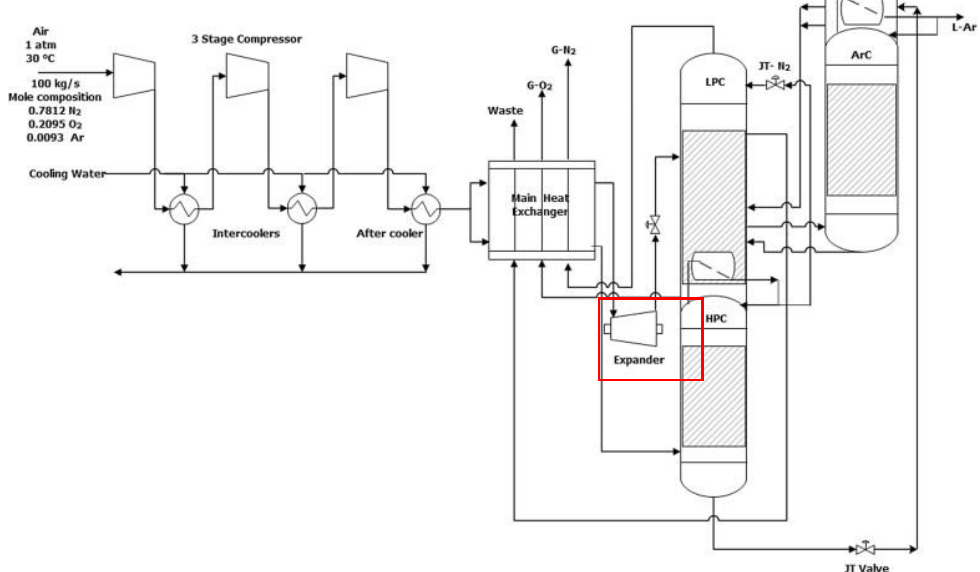
Figure 3. Utilization of expansion turbines in the conventional cryogenic air separation unit with a three-stage compressor. Reproduced with permission from [15]. Copyright 2015, Elsevier.